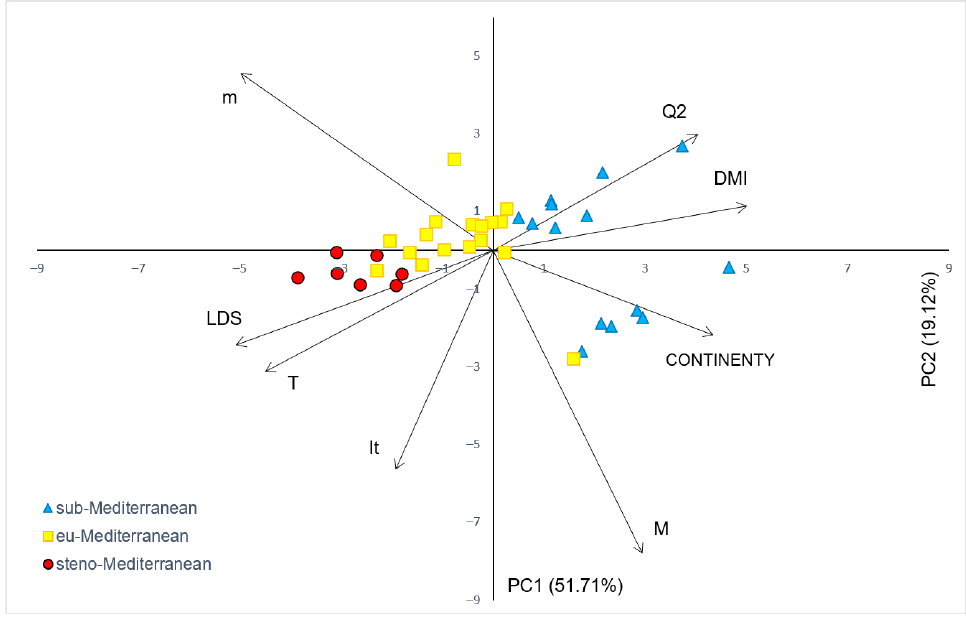
Figure 6. Biplot of the principal component analysis based on bioclimatic variables.